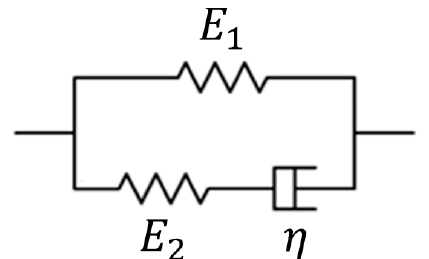
Figure 2. Maxwell form of the standard linear solid model used for describing the viscoelastic behaviors of the material and for developing the principle of ramp-creep ultrasound viscoelastography (RC viscoelastography).